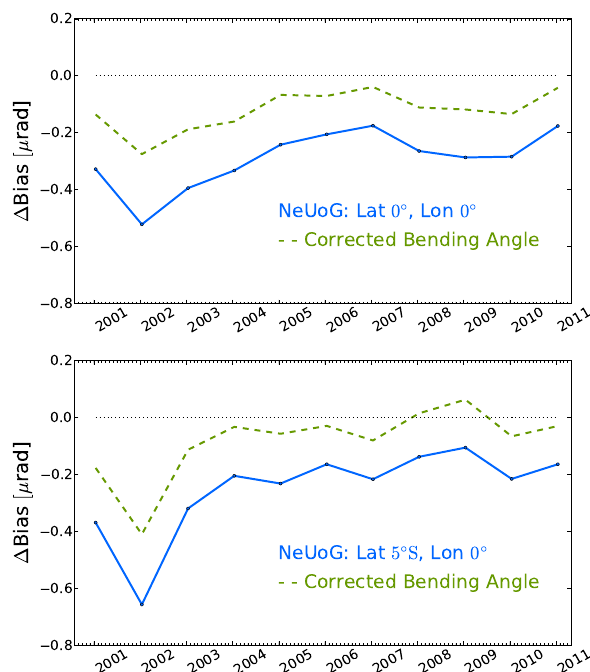
Fig. 7. Bending angle bias difference ( ∆ Bias) between day and night for latitude 0 ◦ (top panel) and 5 ◦ S (bottom panel) for the month January from 2001 to 2011 . The solid blue lines show the bending angle bias difference for original bending angle data sets, the dashed green lines show the data after climatological ionospheric correction.